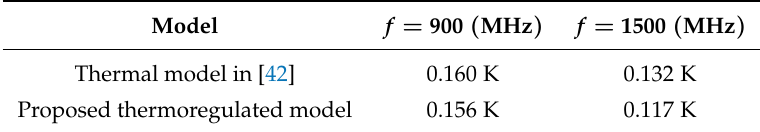
Table 3. Thermal increase comparison inside the brain layer by considering the thermal model published in [42] and the proposed thermoregulated model.